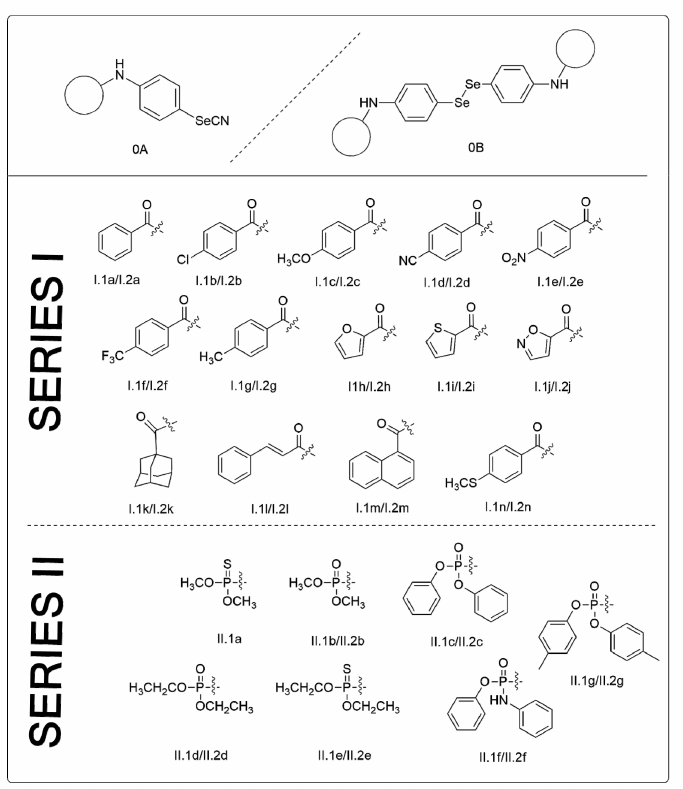
Figure 1. Chemical structures of series I (amides) and II (phosphoramidates). The diselenides derived from 0B were coded as I.1a-n and II.1a-f, and the selenocyanates obtained using 0A as starting material were coded as I.2a-n and